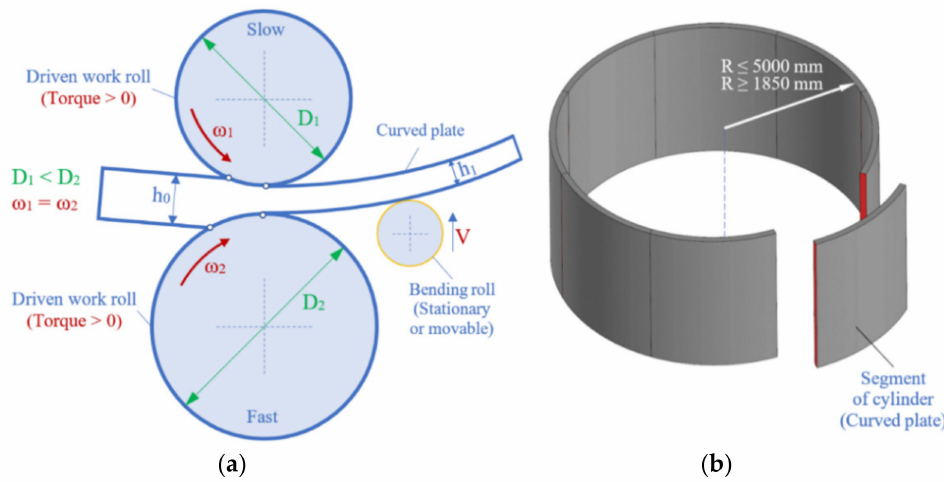
Figure 7. Schematic illustration of combined process of asymmetric rolling and plastic bending ( a ) and a curved plate as a segment of a cylinder ( b